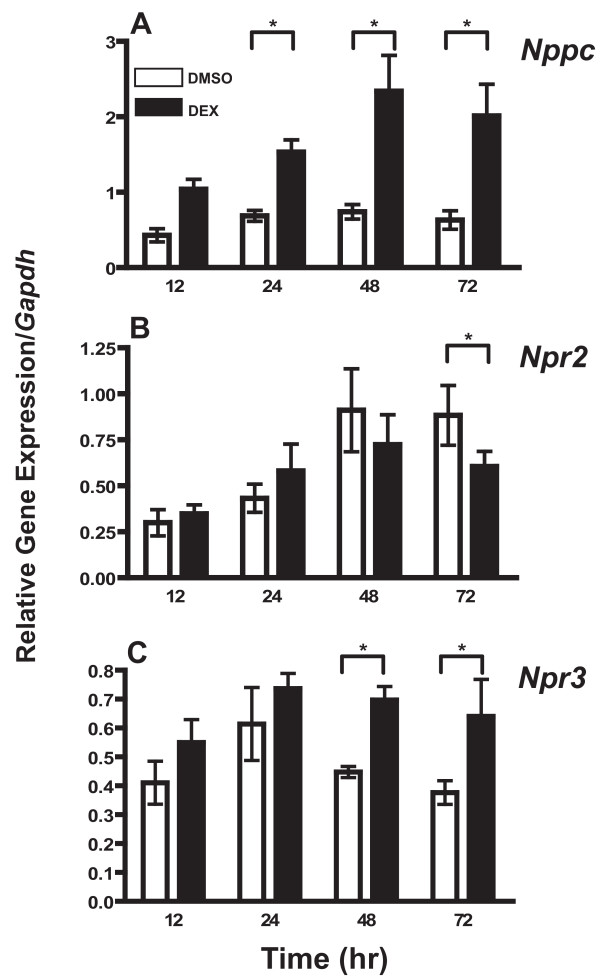
DEX regulates expression of CNP and CNP receptors. Primary chondrocytes were incubated with DMSO or 10-7 M DEX for 12 to 72 hours, and Nppc (encoding CNP, A), Npr2 (encoding the CNP signaling receptor, B) and Npr3 (encoding the CNP decoy receptor, C) mRNA levels were determined by real-time PCR relative to Gapdh. Nppc expression is significantly increased upon DEX treatment, while DEX down-regulated Npr2 slightly and up-regulated Npr3 at the 48 and 72 hr time points. Data represent mean ± SEM from three or four independent trials (*P < 0.05).